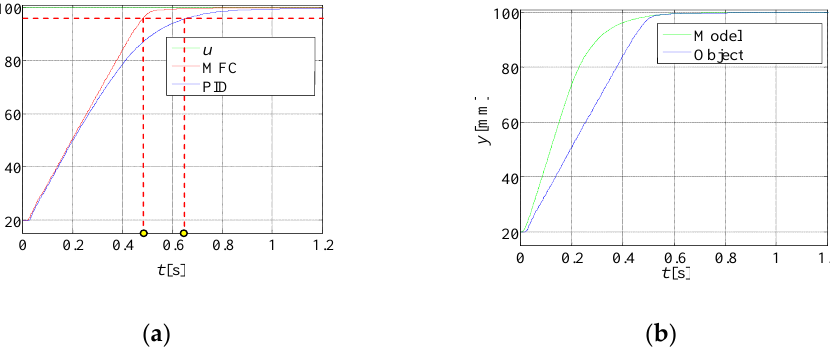
Figure 15. ( a ) Comparison of MFC i PID controller (red line — settling time); ( b ) piston rod displacement for MFC regulator and EHSD model in main controller loop ( p 0 = 8 MPa, F L = 1477 N).